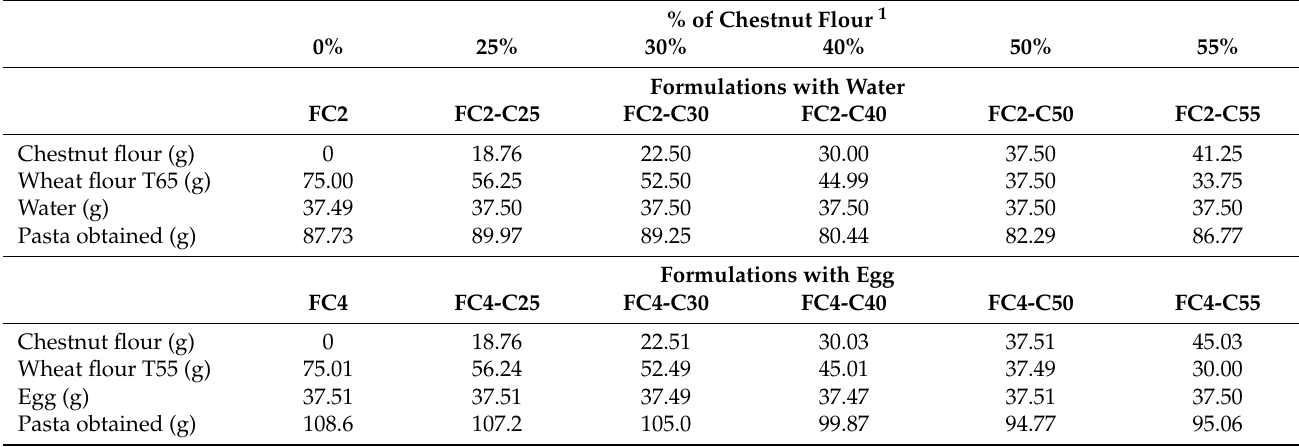
Table 2. Incorporation of chestnut flour into the control formulations with water and egg.